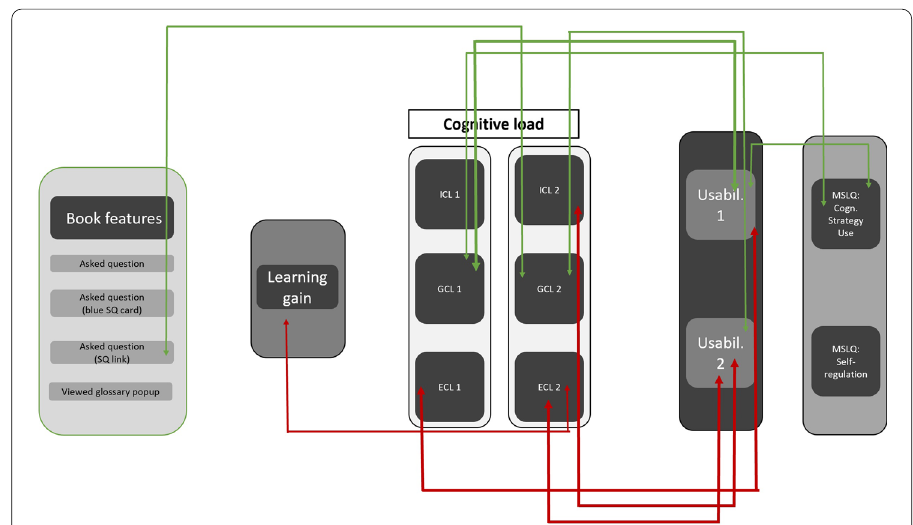
Fig. 5 Statistically significant correlations between variables investigated in the study. “1” and “2” indicate measuring points (start and close of the study). Positive correlations in green and negative correlations in red. Arrow thickness represents relationship